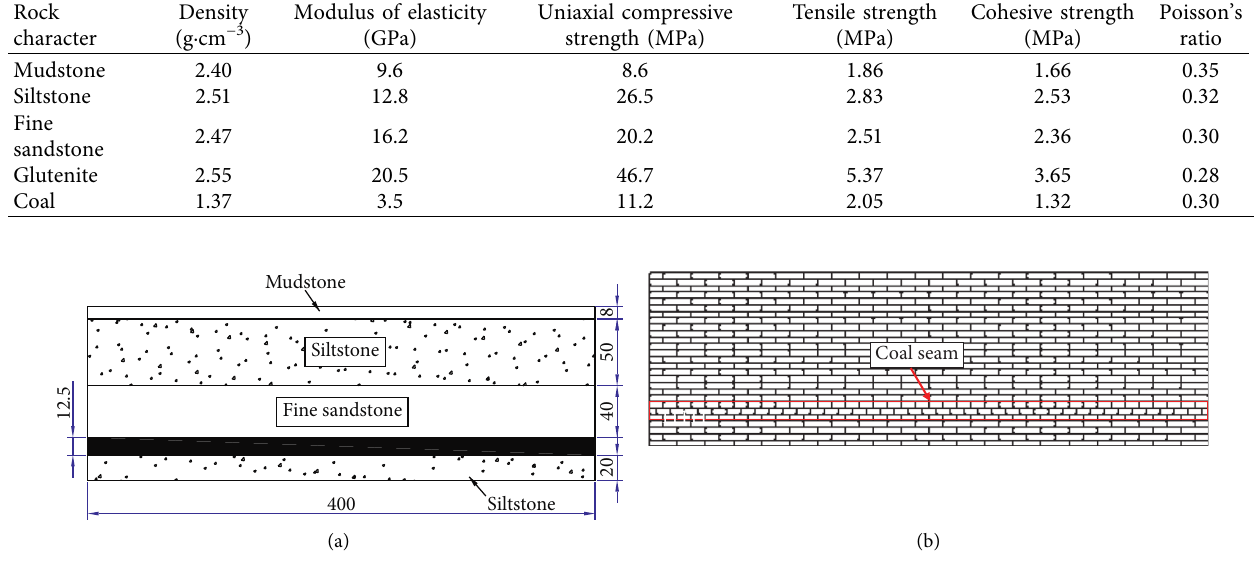
Figure 4: Coal mining model diagram of the upper group. (a) CAD design drawing. (b) UDEC model diagram.